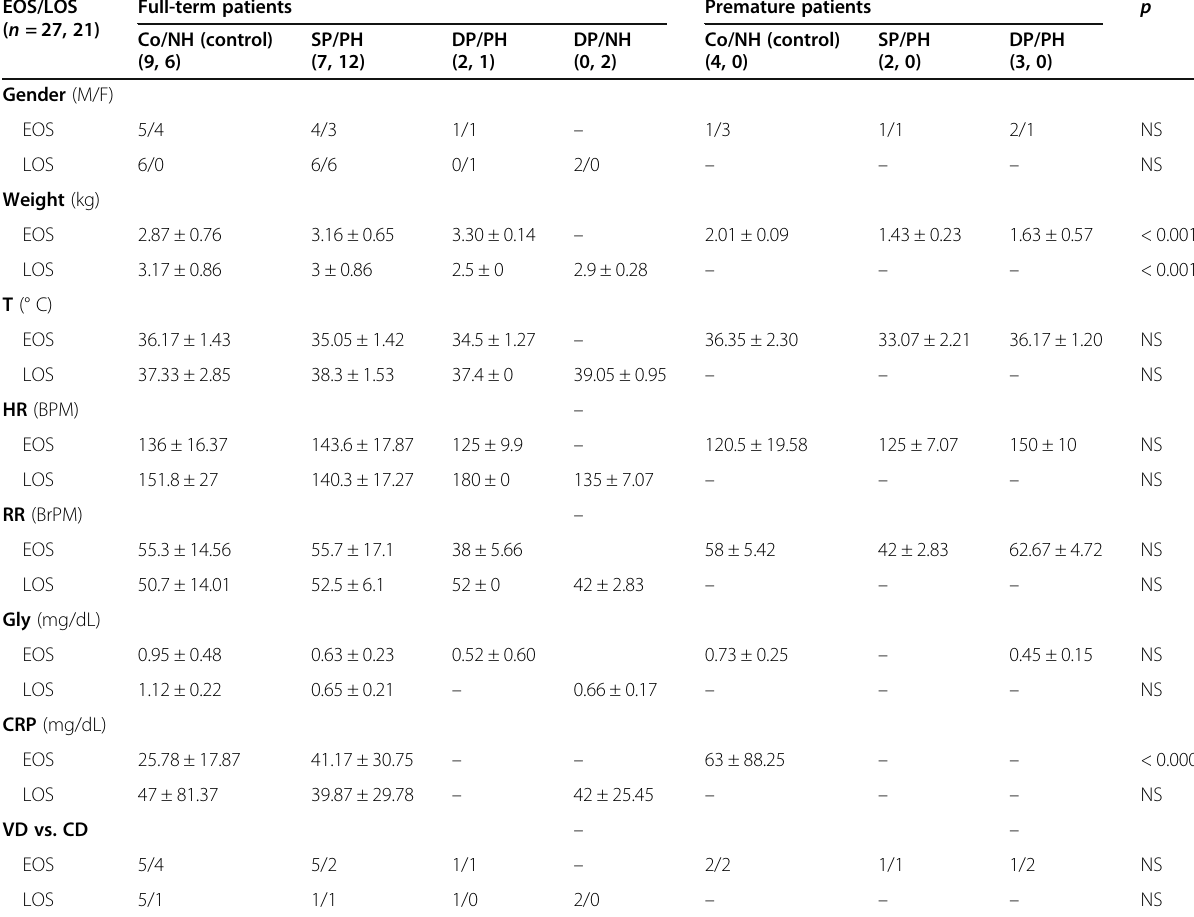
Table 1 Characteristics of the newborn patients with sepsis in the present study EOS/LOS ( n = 27,